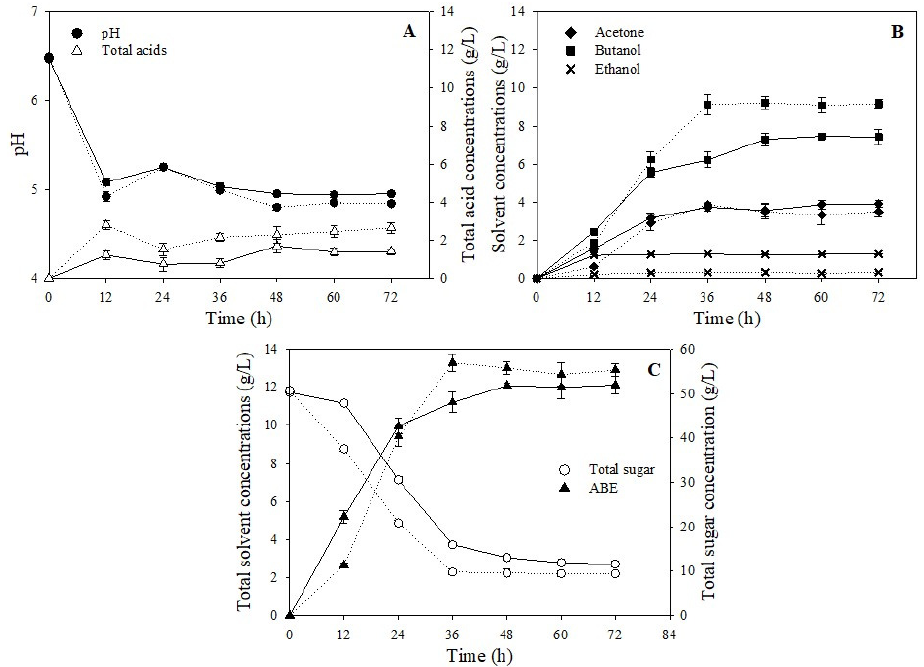
Figure 3. Profiles of ABE fermentation from sugarcane molasses by C. beijerinckii TISTR 1461 in 1-L screw capped bottles without (solid line) and with (dotted line) DSY addition. ( A ): pH and total acid, ( B ): acetone, butanol and ethanol and ( C ): total solvent and total sugar.